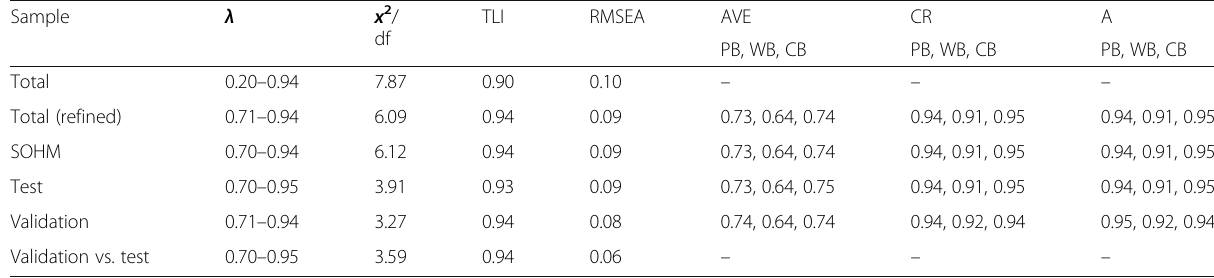
Table 1 Confirmatory factor analysis (CFA), convergent validity, and reliability of the CBI-Br to different samples